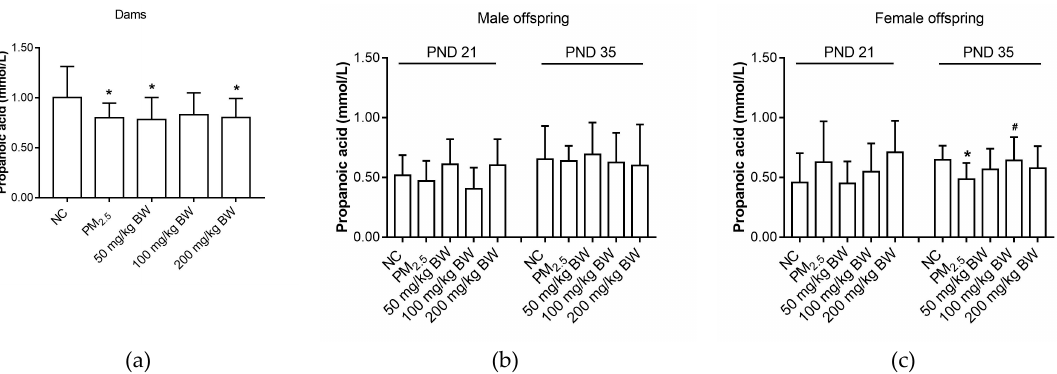
Figure 3. Propanoic acid concentrations of dams and o ff spring. ( a ) Propanoic acid of dams on PND 21. ( b ) Propanoic acid of male o ff spring on PND 21 and PND 35. ( c ) Propanoic acid of female o ff spring on PND 21 and PND 35. The data was expressed as mean ± SD of each group. Compared with the NC group, * indicates p < 0.05. Compared with the PM 2.5 group, # indicates p < 0.05.